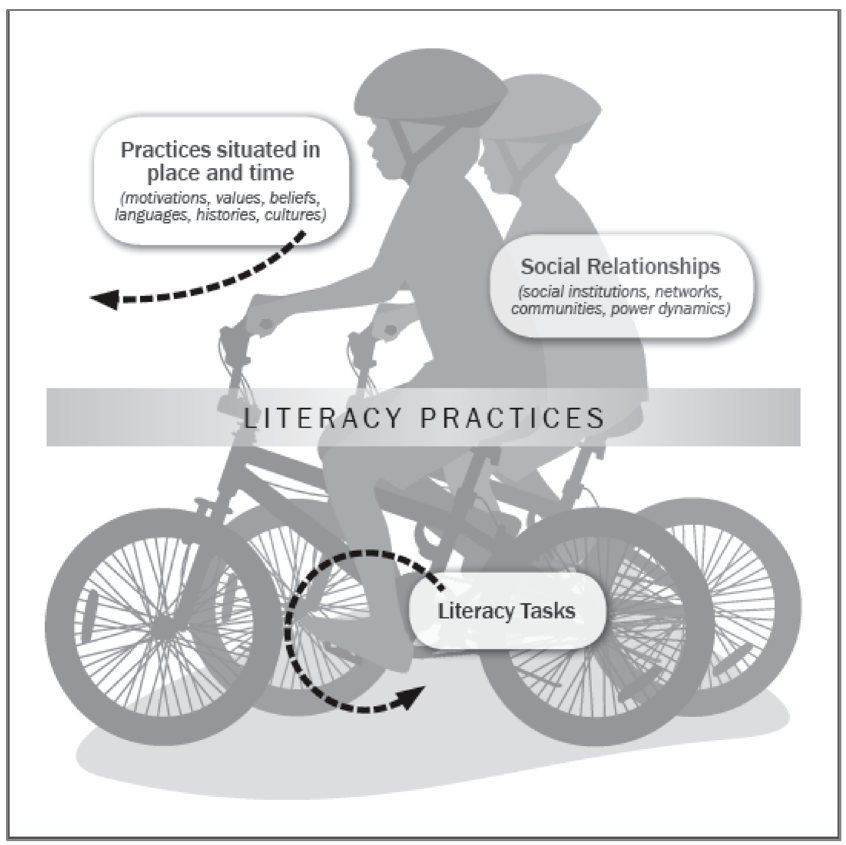
Figure 1. Understanding immigrant adolescent health literacy as socially situated practice: A bike- riding